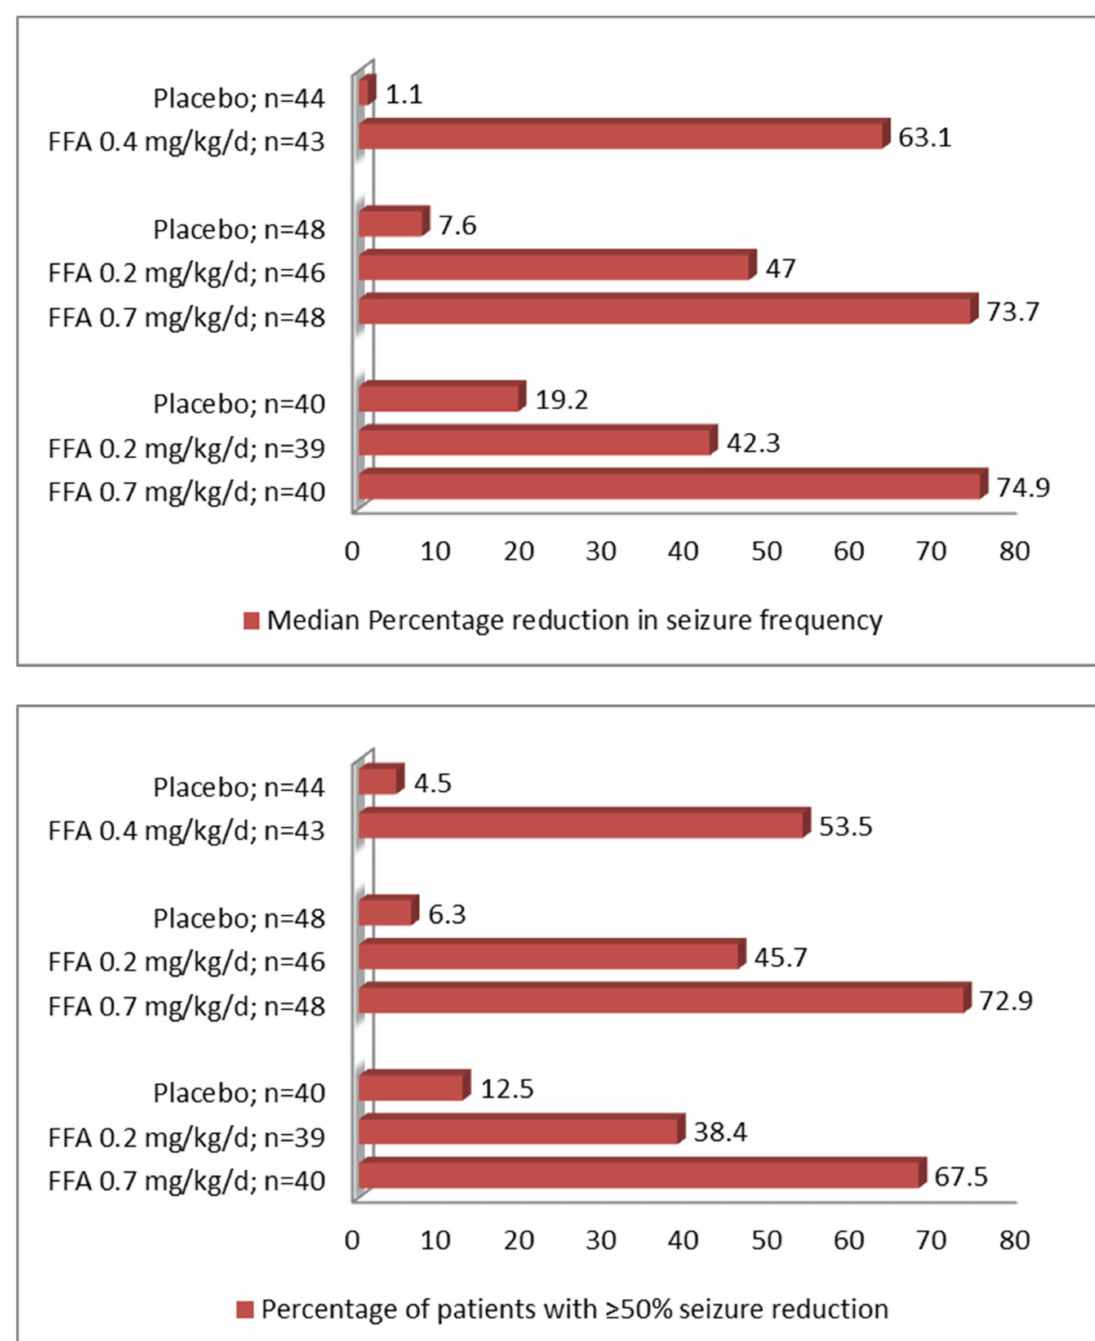
Figure 1. Median percent reduction from baseline in monthly convulsive seizure frequency and ≥ 50% seizure-responder rates as reported in three randomized controlled trials of fenfluramine in patients with Dravet syndrome (From bottom to up: [36,55,56]) values with statistical comparison were documented in the